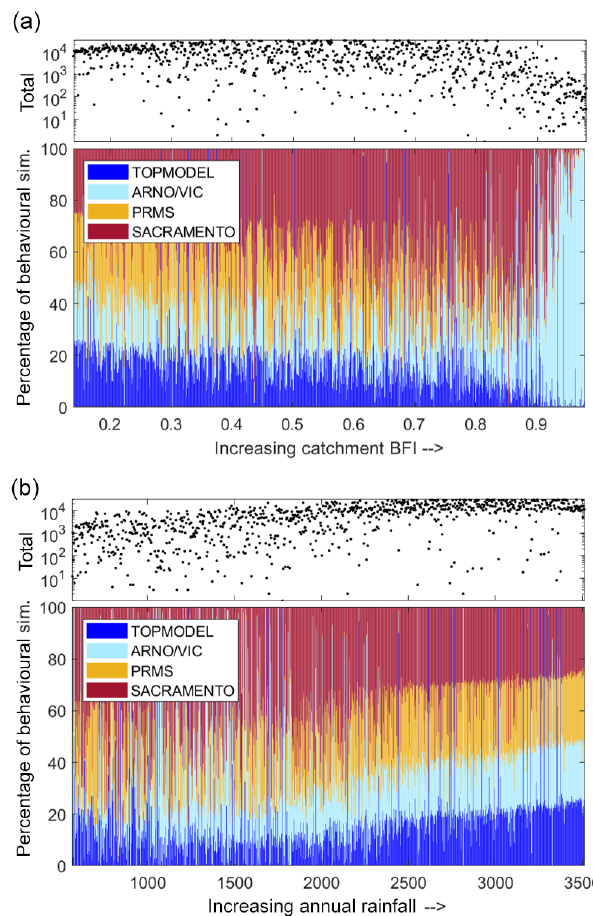
Figure 8. Relative performance of the four FUSE model structures, depending on catchment characteristics. Scatter plots show the to- tal number of behavioural simulations, from all model structures, forming each line on the stacked bar graph. Each line on this stacked bar chart represents one catchment, and the colour shows the pro- portion of the behavioural simulations from each model structure. Catchments have been ordered by BFI (a) and annual rainfall (b)